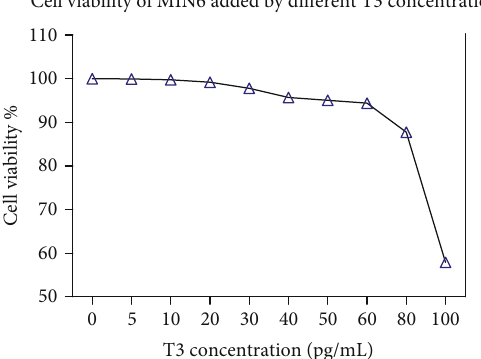
Figure 1: The e ff ect of di ff erent concentrations of T3 on the activity of MIN6 cells. In this study, the CCK8 method was used to detect the e ff ect of di ff erent concentrations of T3 on the activity of MIN6 cells. When the concentration of T3 is lower than 80 pg/mL, there is no e ff ect on the activity of MIN6